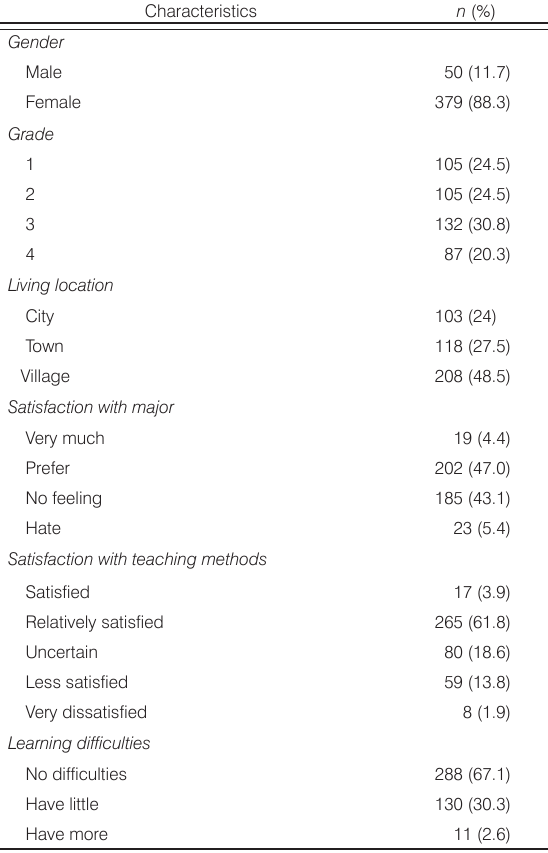
Table 1. Demographic characteristics of the participants ( n =429)